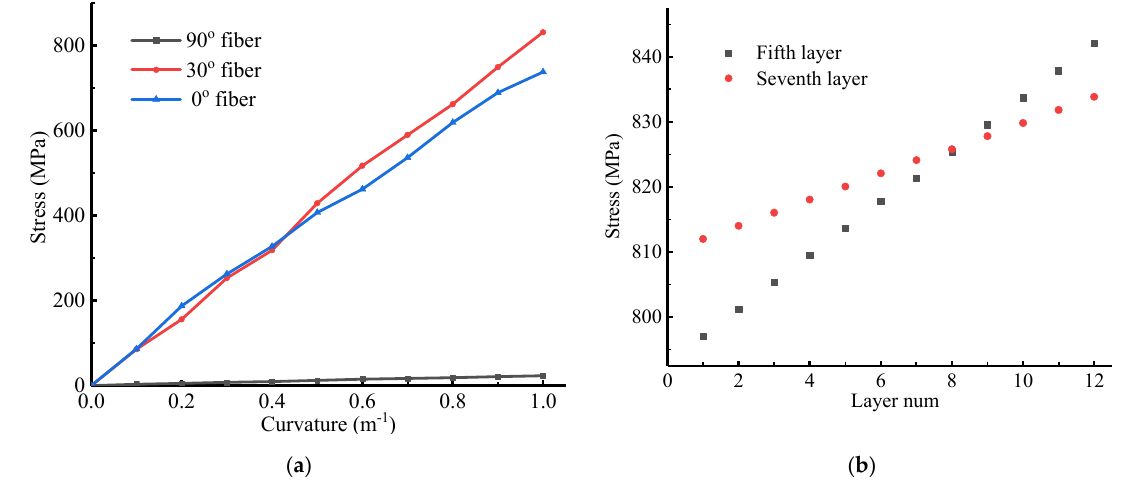
Figure 14. Fiber stress of composite tension armor. ( a ) Fiber stress versus curvature per unit length; ( b ) the stress of fiber at 0° versus curvature per unit length.